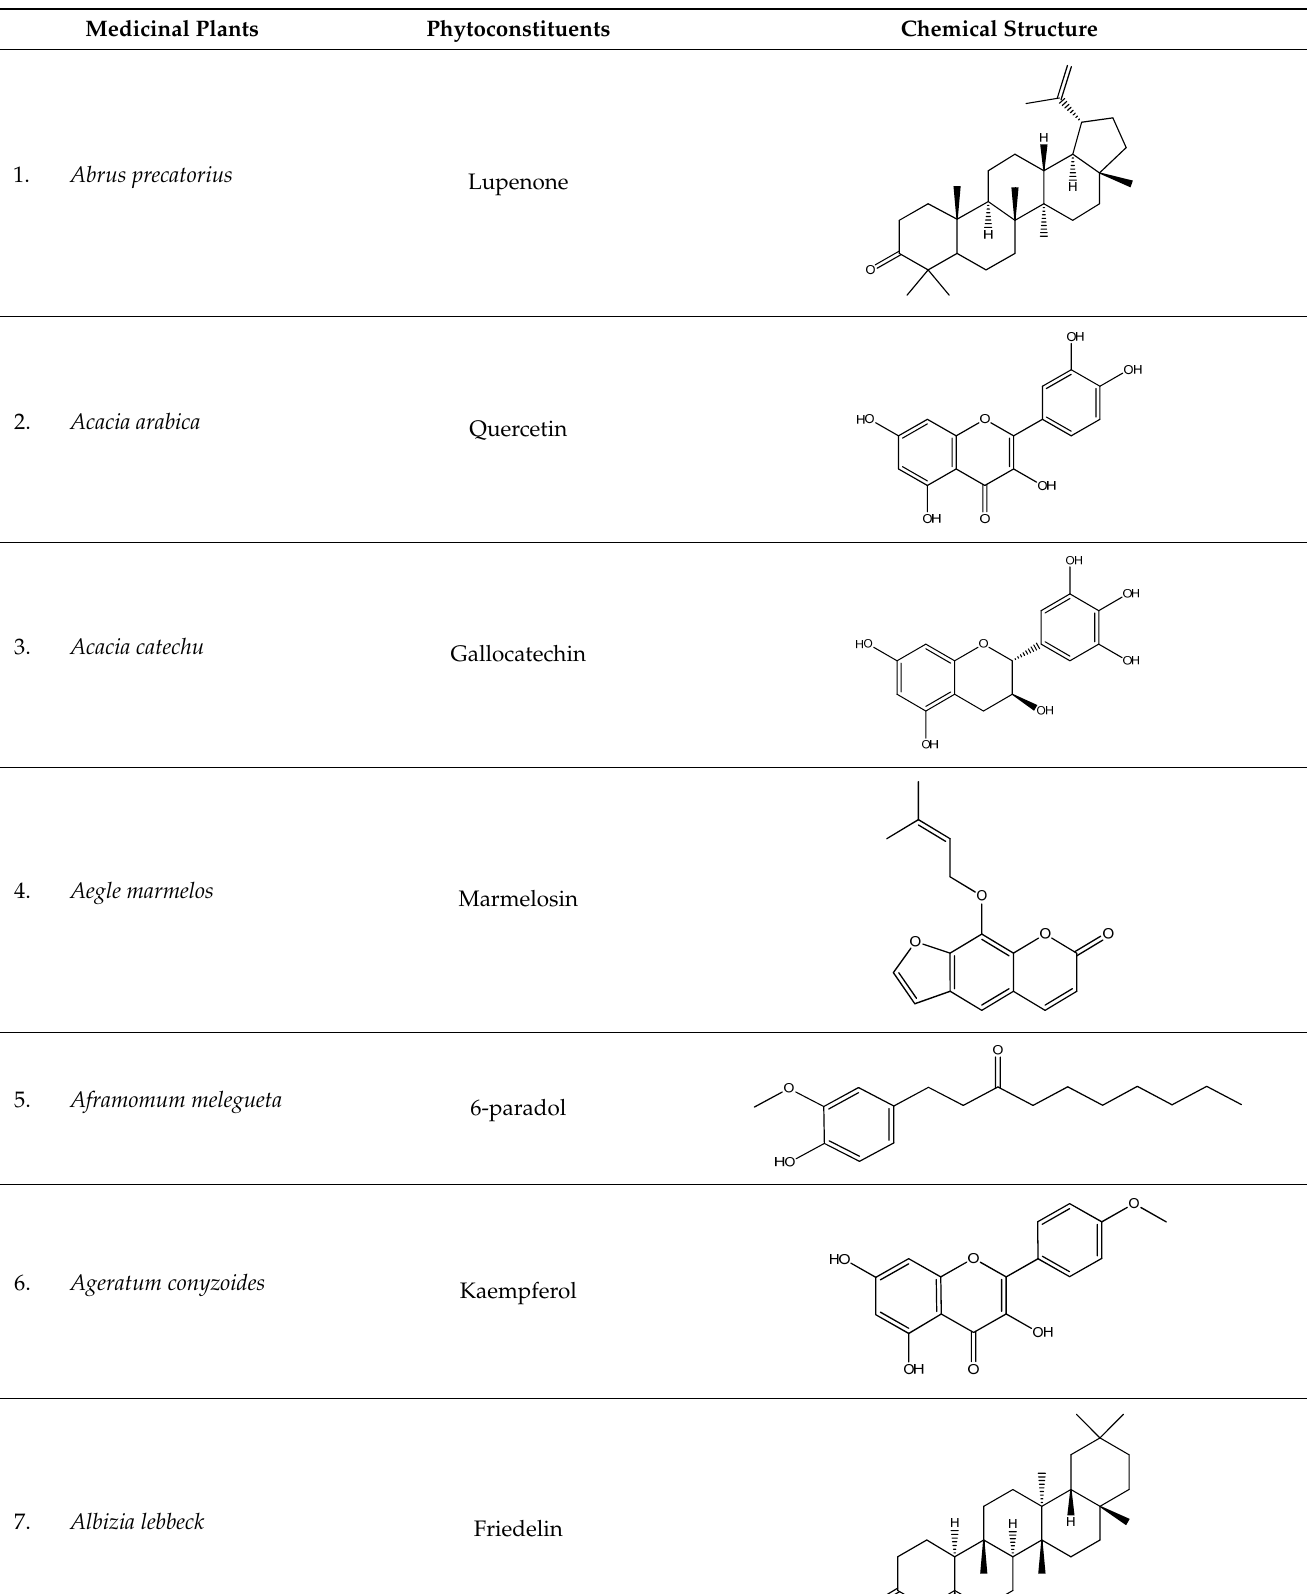
Table 3. Antidiabetic phytoconstituents of medicinal plants and their chemical structures. Medicinal Plants Phytoconstituents Chemical